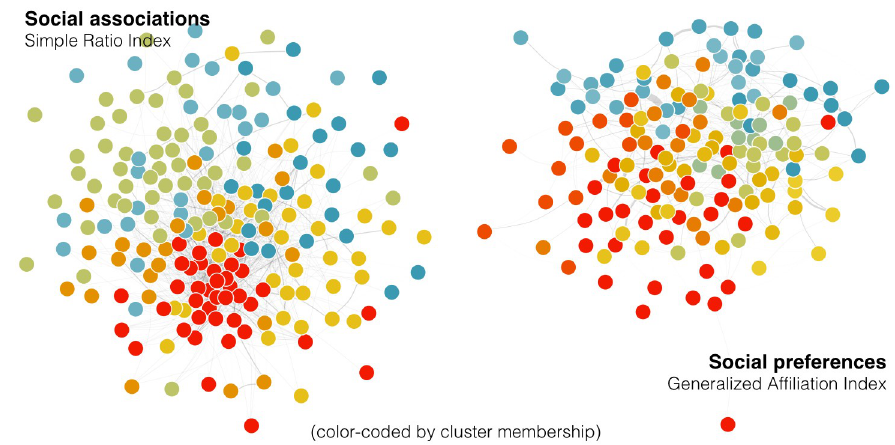
Fig 5. Social networks, color-coded by community membership as identified by the Louvain clustering algorithm in igraph , of humpback whales ( � 5 encounters) in the Kitimat Fjord System. The left network is based upon social associations (weighted by the Simple Ratio Index) and contains 7 identified communities. The right network includes the network of social preferences (weighted by the Generalized Affiliation Index), with 13 identified communities.